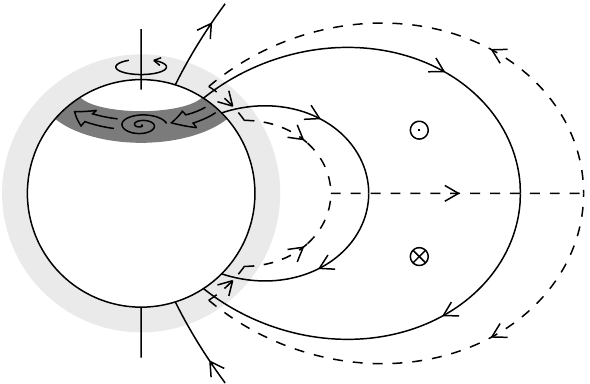
Fig. 1. Sketch of the Hill current system. Equatorward Peder- sen currents in the ionosphere (light grey shaded region) close in the equatorial magnetosphere, acting to transfer angular momen- tum from the upper atmosphere to the magnetosphere. The cur- rents (dashed lines) induce an azimuthal magnetic field which bends the planetary field lines (solid lines) out of the meridian planes. The region of the atmosphere coupled to this current system (dark grey shaded region) is expected to be dominated by subcorotational winds. However, an axial asymmetry in this region will lead to an axial asymmetry in the coupling currents and thus in the magnetic field